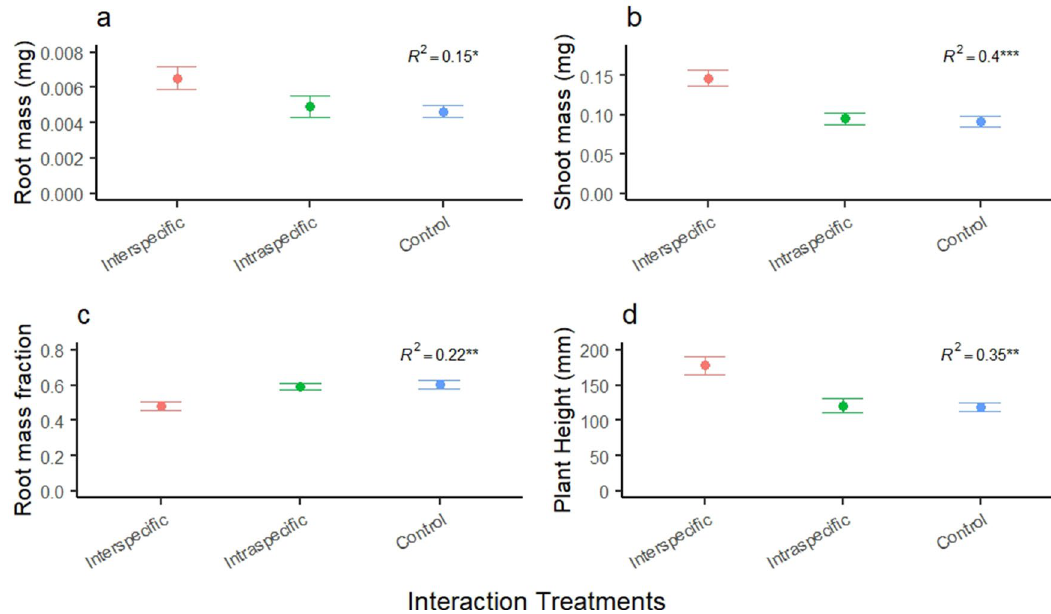
Figure 2. Mean ± standard error of the treatment groups for Pascopyrum smithii plants growing alone, and with intraspecific and interspecific neighbors for ( a ) shoot mass, ( b ) root mass, ( c ) RMF (root mass fraction), and ( d ) plant height. Significance levels are denoted by ns P > 0.5; * P ≤ 0.05; ** P ≤ 0.01; *** P ≤